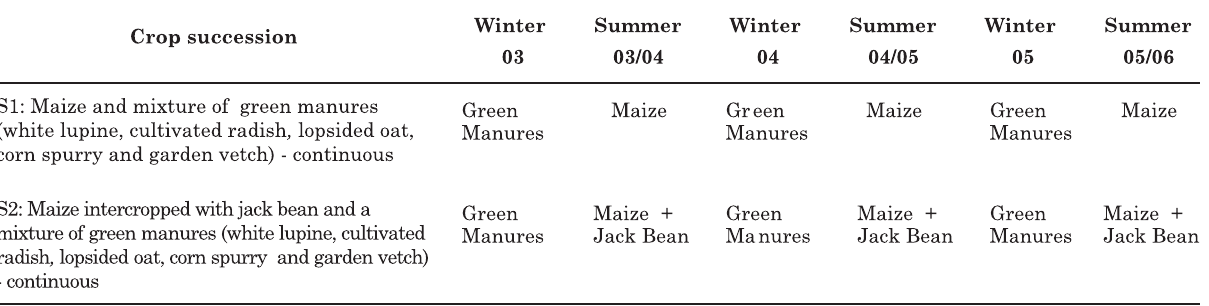
Table 2. Succession systems of the crops